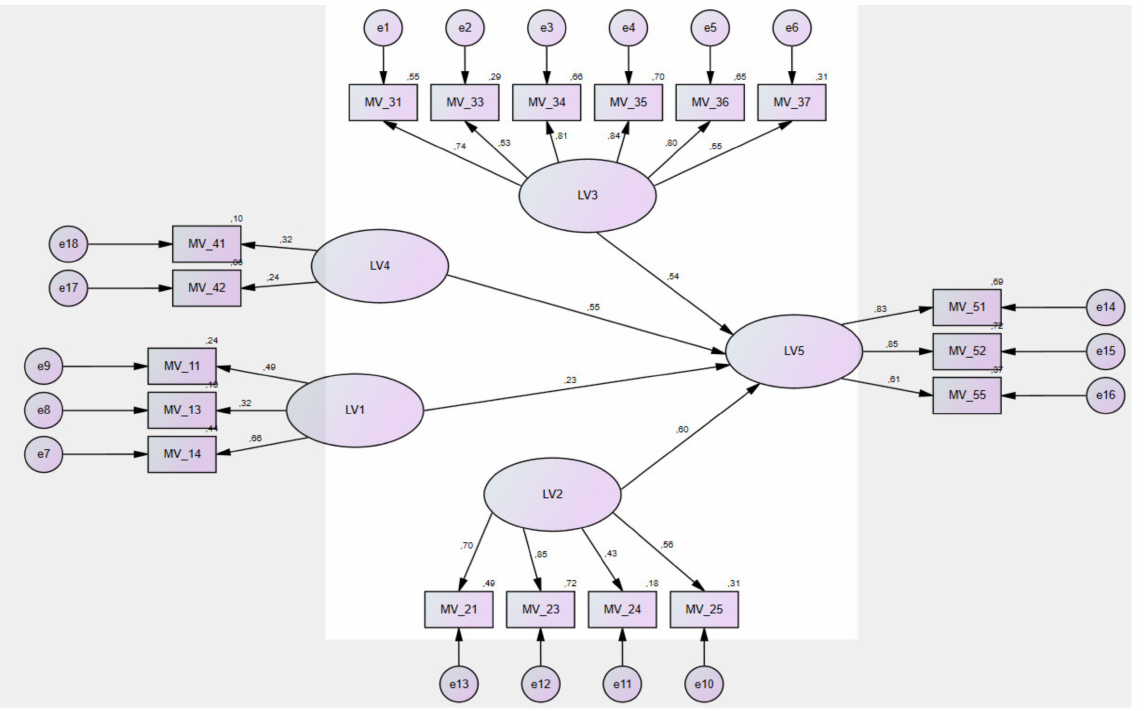
Figure 1. Final SEM model. Source: own research.